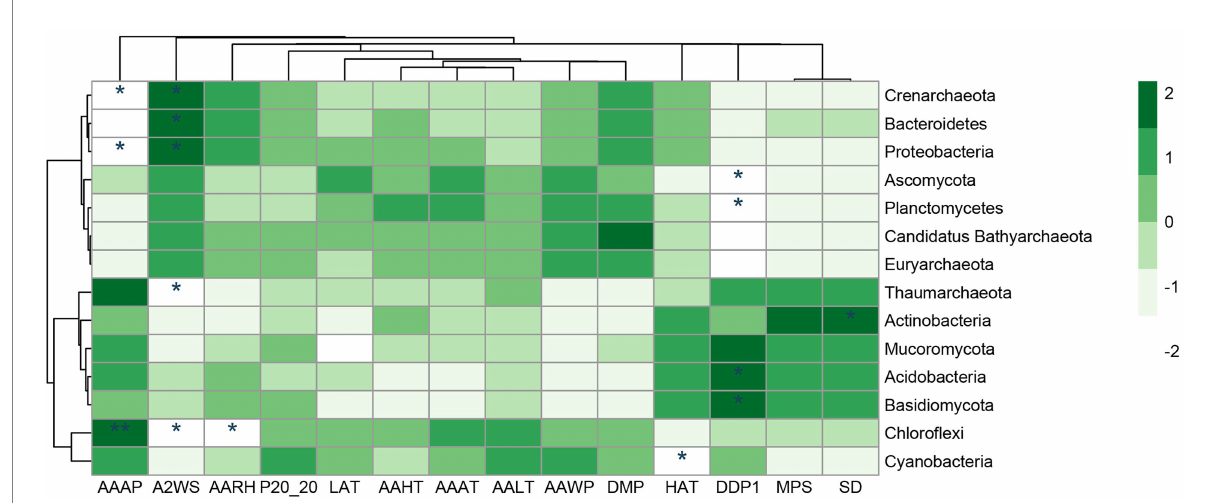
FIGURE 6 Correlation analysis between different taxa and meteorological data at phylum taxa level. AAAP, annual average atmospheric pressure (hPa); A2WS, average 2 min wind speed (m/s); AARH, annual average relative humidity (%); P20-20, recipitation of 20 p.m. − 20 p.m. (mm); LAT, the lowest air temperature (°C); AAHT, annual average highest temperature (°C); AAAT, annual average air temperature (°C); AALT, annual average lowest temperature (°C); AAWP, annual average water pressure(hPa); DMP, daily maximum precipitation (mm); HAT, the highest temperature (°C); DDP1,